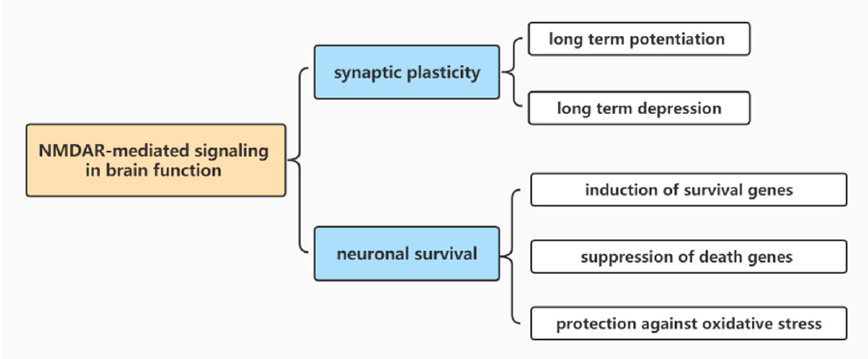
Figure 1. NMDAR-mediated signaling in brain functioning.